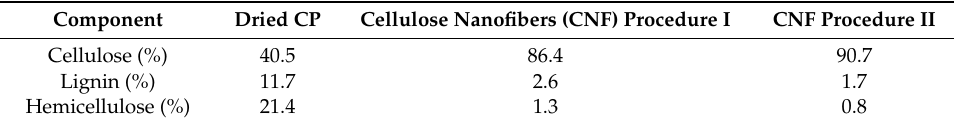
Table 1. The chemical composition of cassava peel (CP) and CP nanofibers.